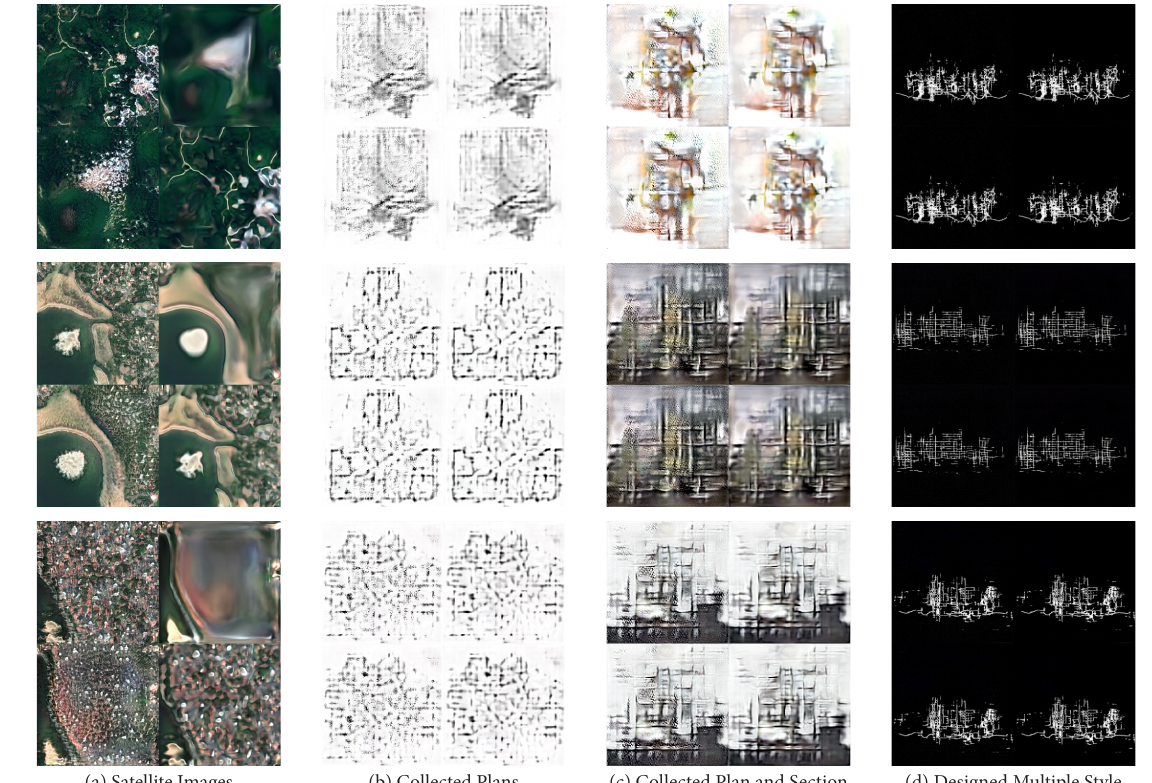
Figure 12. These are noise effects on different layers: ( a ) Noise effect from satellite images training. ( b ) Noise effect from collected plan drawings training. ( c ) Noise effect from collected plan and section training. ( d ) Noise effect from designed multiple-style drawings